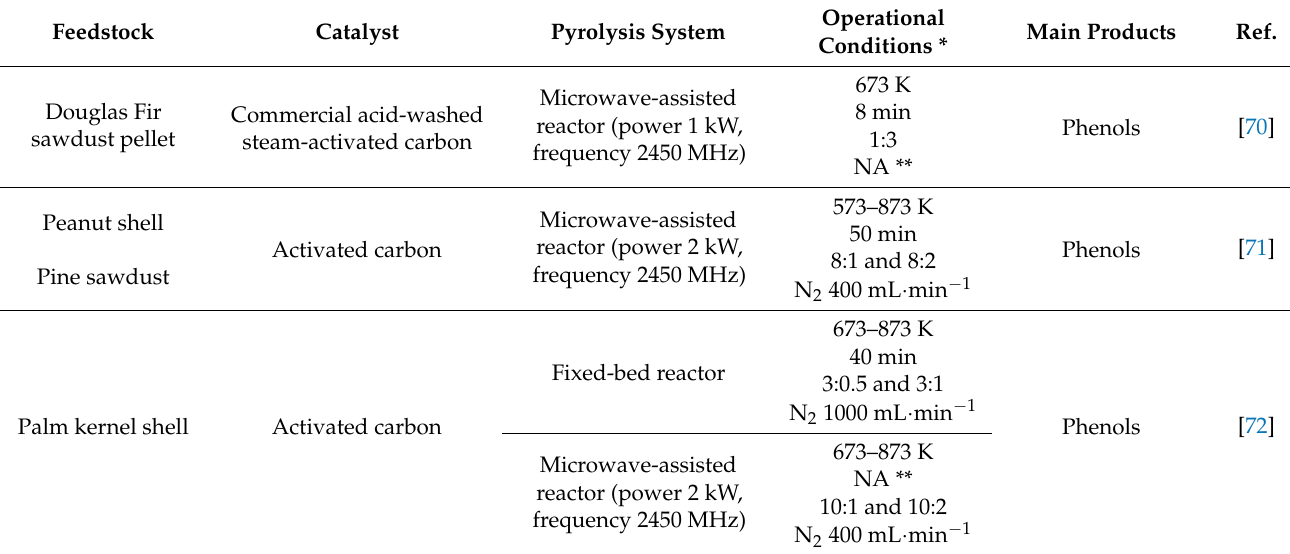
Table 1. Activated carbon catalysts applied to catalytic pyrolysis of